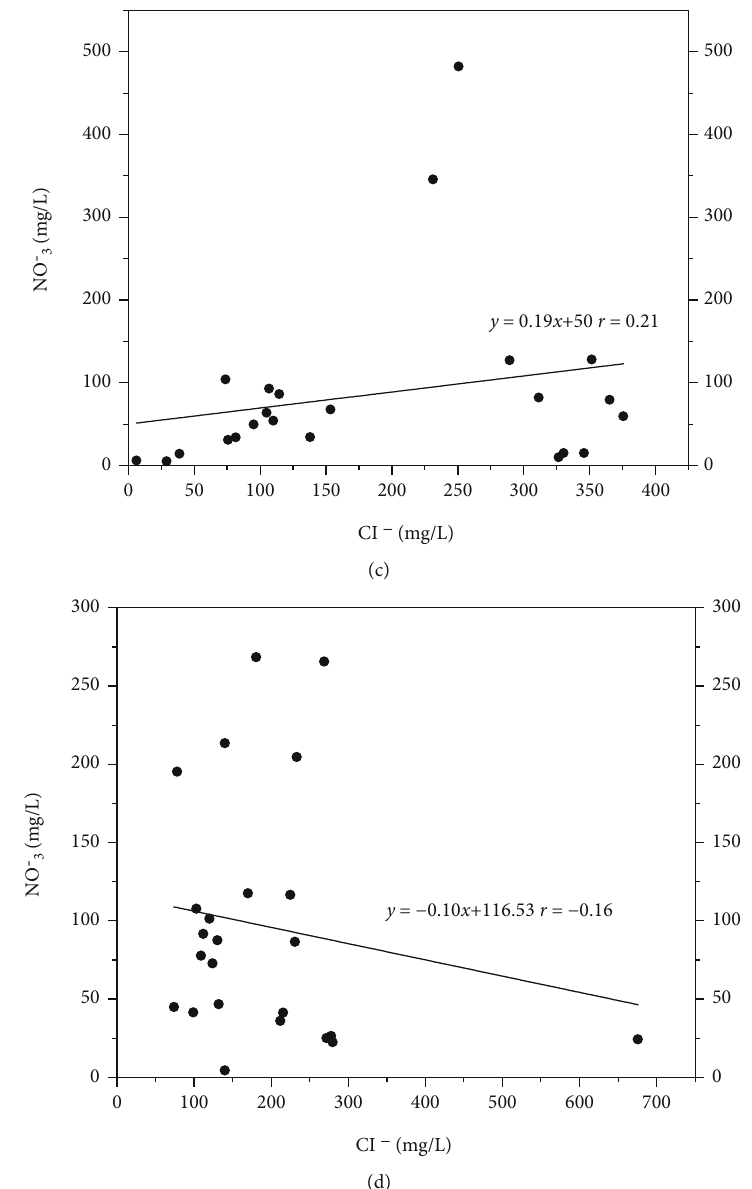
− and Cl − in shallow wells during the (a) wet and (b) dry seasons and in boreholes during the (c) wet and (d) dry 3